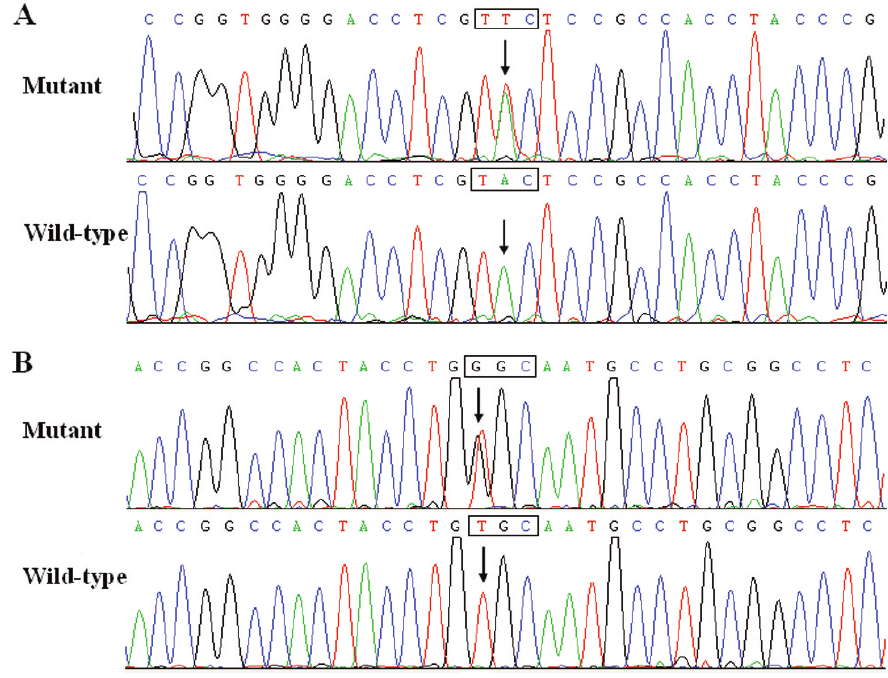
Figure 1 - Sequence electropherograms showing the GATA5 mutations in contrast with their corresponding controls. The arrow indicates the heterozygous A/T (Figure 1A) and T/G (Figure 1B) nucleotides in the probands from Families 1 and 2, respectively, (mutant) or the homozygous A/A (Figure 1A) and T/T (Figure 1B) nucleotides in the corresponding controls (wild-type). The square denotes the nucleotides comprising a GATA5 codon.